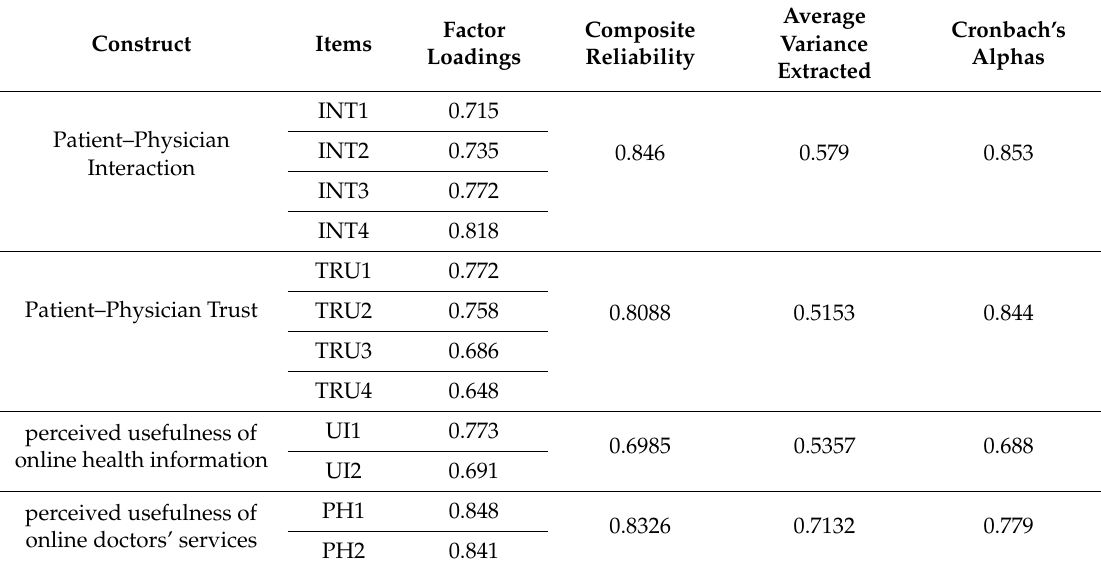
Table 3. Item loadings and validities.